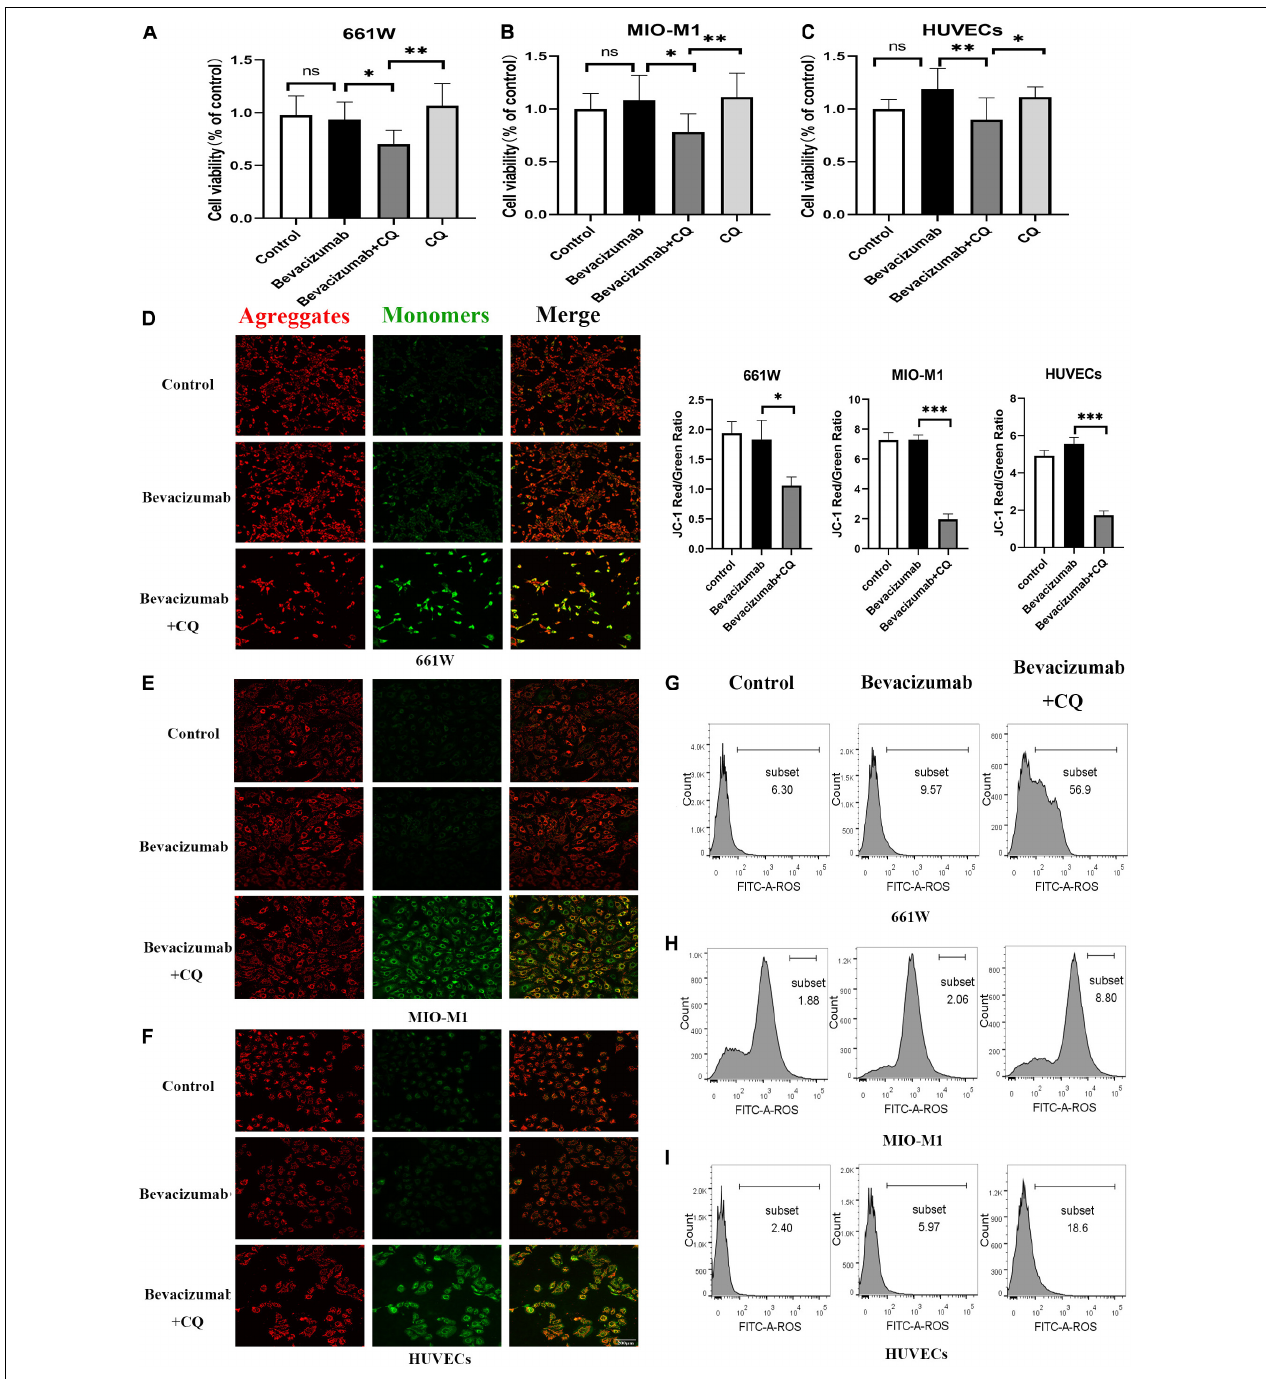
FIGURE 6 | Hypoxia-inducible factor-1 α -mediated mitophagy prevented bevacizumab-induced ROS accumulation and apoptosis in vitro : Cultured 661W photoreceptors, MIO-M1 Müller cells, and HUVECs were treated with bevacizumab or CQ alone, bevacizumab plus autophagy inhibitor CQ under hypoxia (A–C) cell viability was analyzed by CCK-8. ( D–F) Mitochondrial membrane potential was analyzed by JC-1staing. Bar: 200 µ m. (G–I) ROS was analyzed by DCFH-DA staining and flow cytometry. ns: no significance, ∗ P < 0.05, ∗∗ P < 0.01, ∗∗∗ P < 0.001.